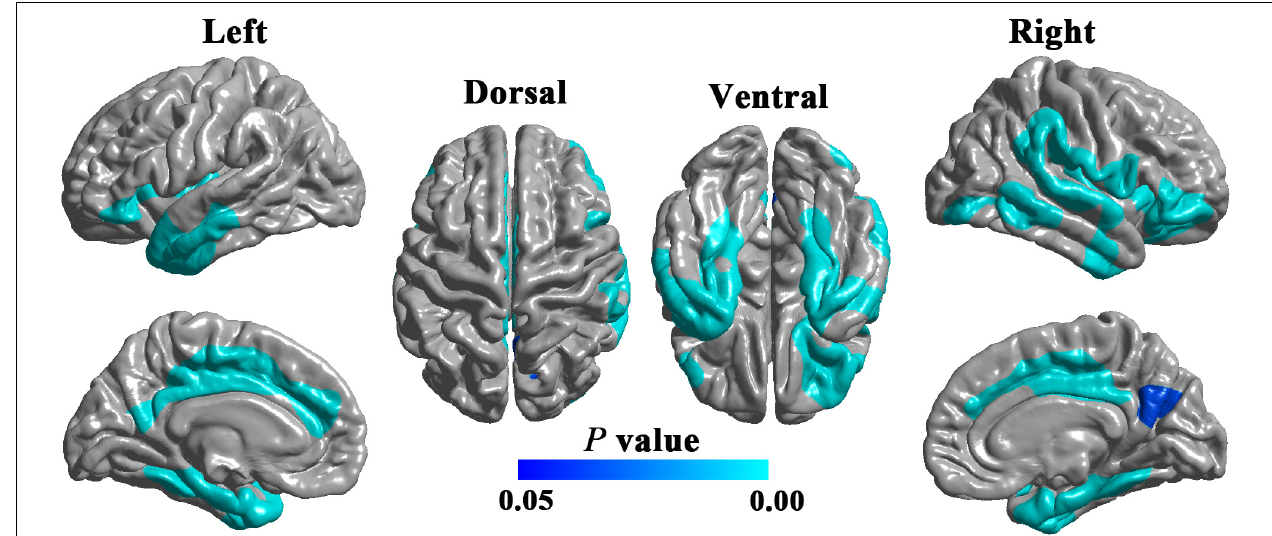
FIGURE 1 | Cortical regions showing significantly decreased cortical thickness in DPN patients compared with HCs (RFT-corrected P <